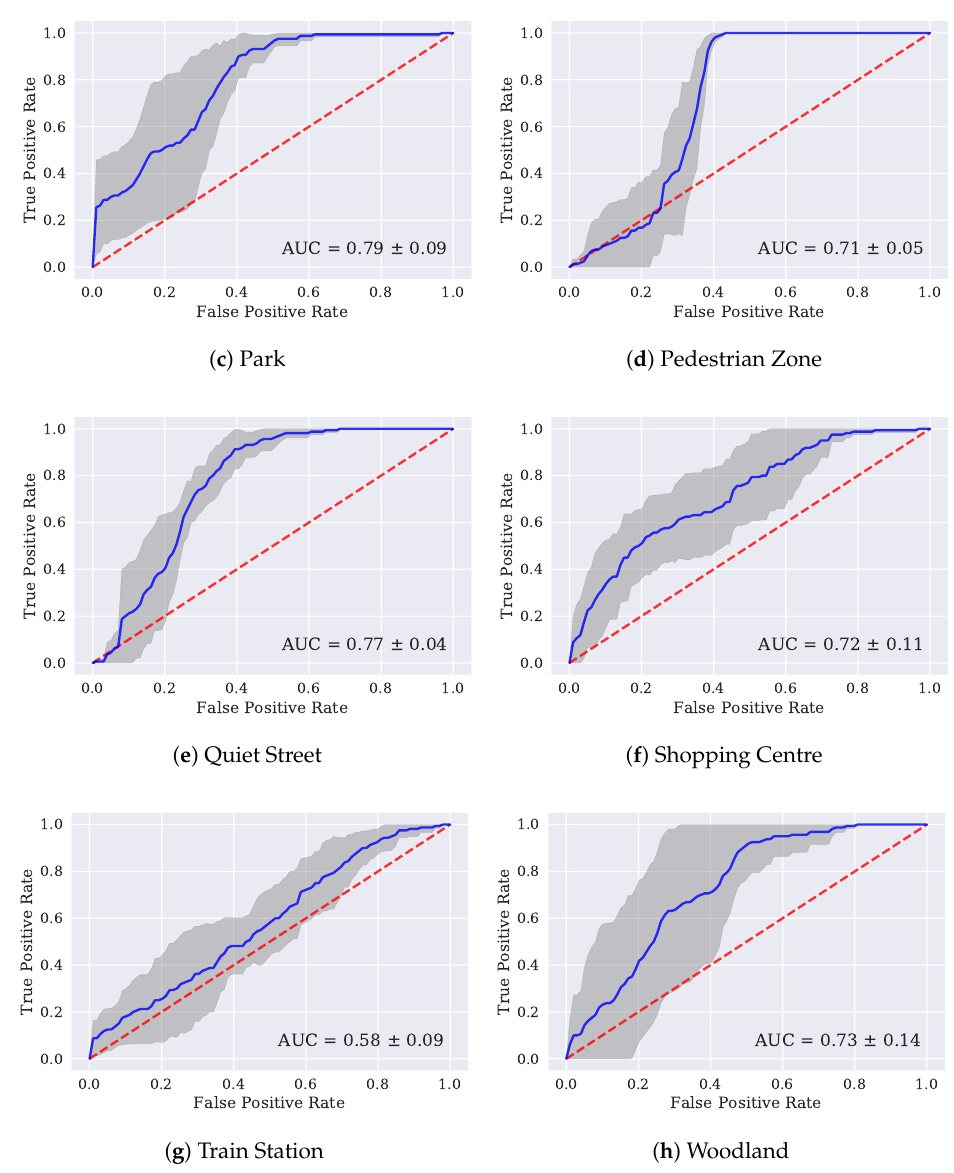
Figure 6. Receiver operating characteristics (ROC) curves for each scene classifier, showing mean (solid line) and standard deviation (grey area) of the curves calculated using results across all folds. Dotted line represents chance performance. AUC: area under the